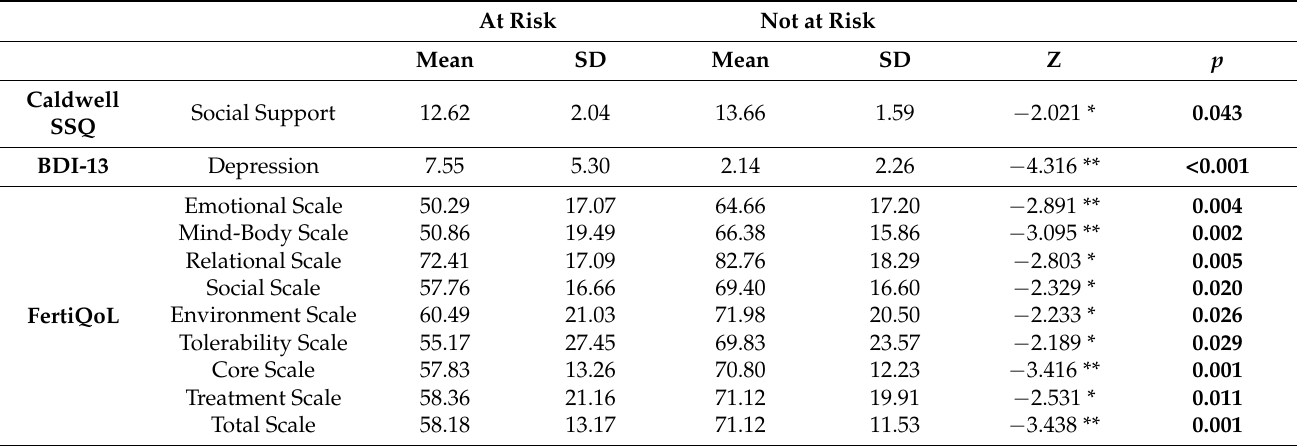
Table 7. Differences between women classified as at risk and not at risk regarding social support (Caldwell SSQ), depression (BDI-13), and fertility-related quality of life (FertiQoL). At